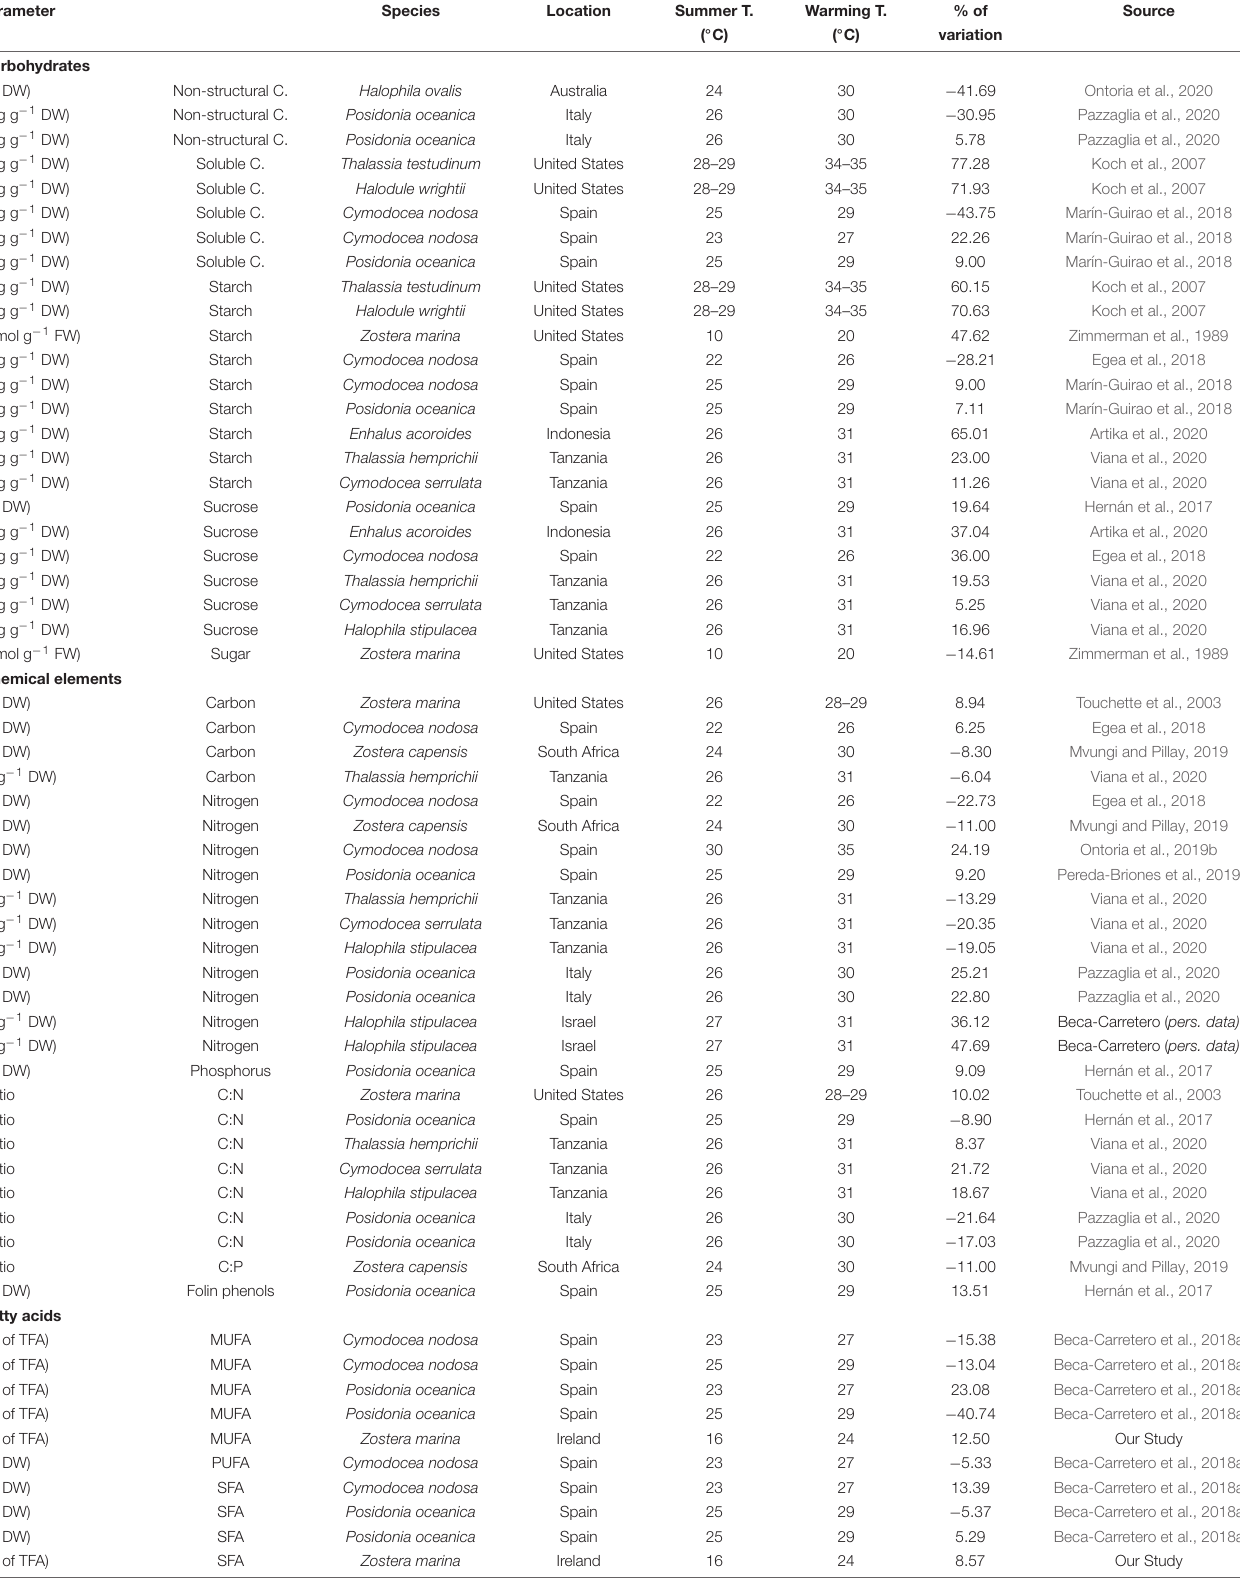
TABLE 2 | Literature review of the effects of temperature in the nutritional composition of seagrasses leaf.